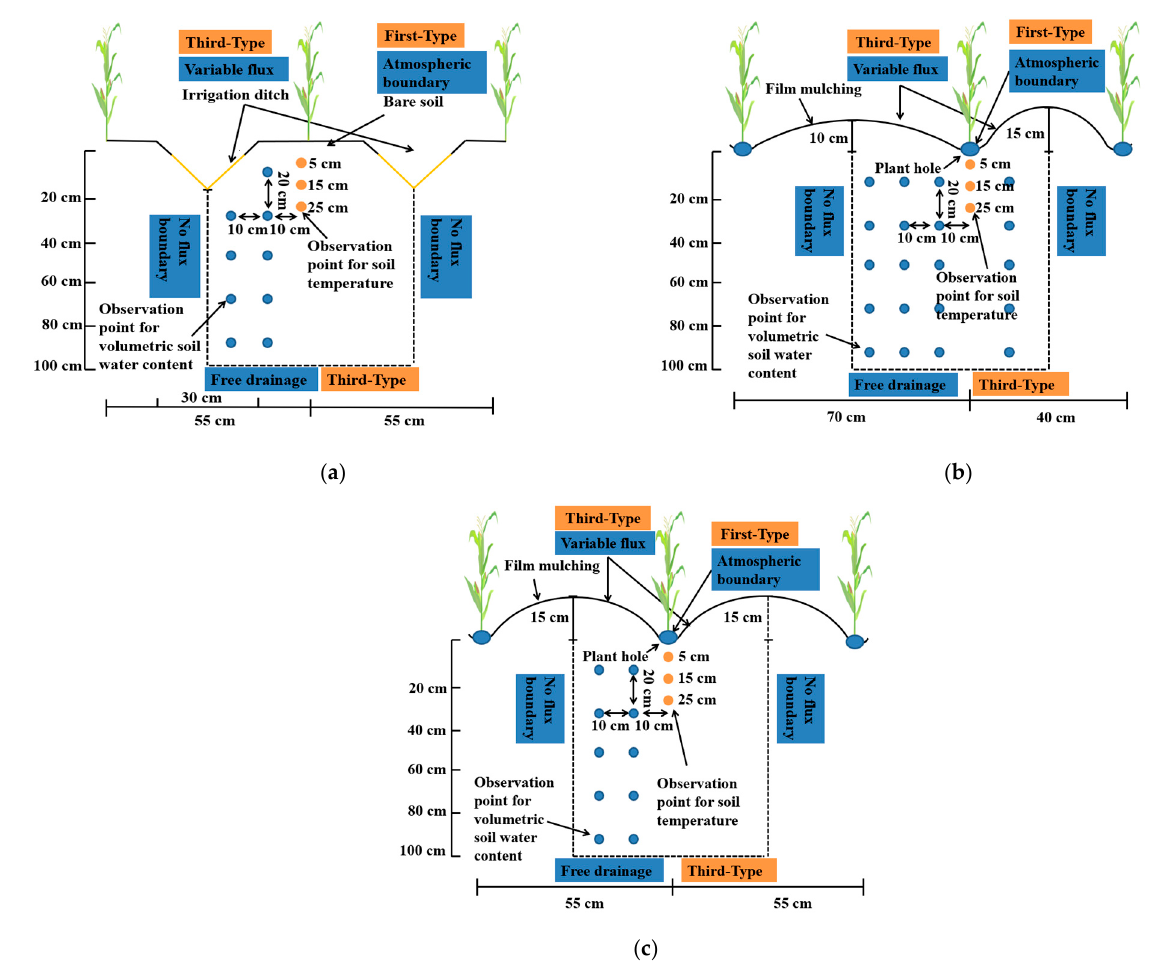
Figure 2. Experimental layout and observation nodes, boundary conditions for soil water and heat flow under different treatments in HYDRUS-2D modeling. ( a ) Treatment CK; ( b ) Treatment RFWN; ( c ) Treatment